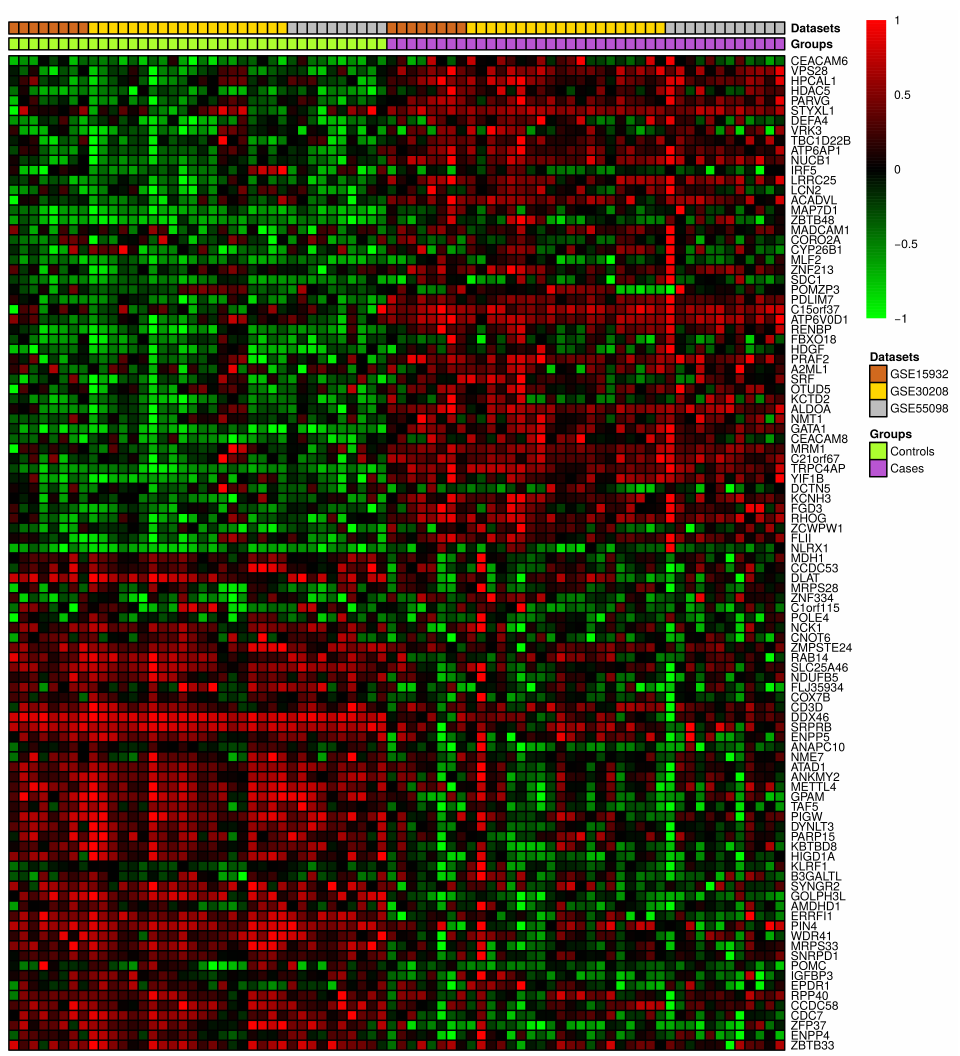
Figure 6. The heatmap depicting the top 100 differentially expressed genes in three previously released GEO diabetes